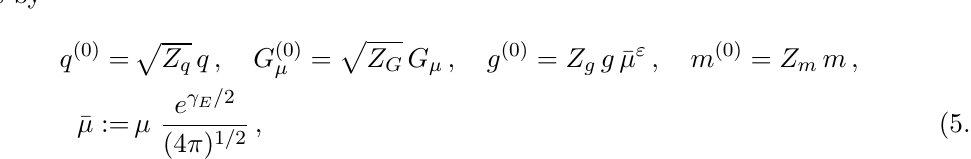
; (cid:13) g , which are matrices (cid:22) 5